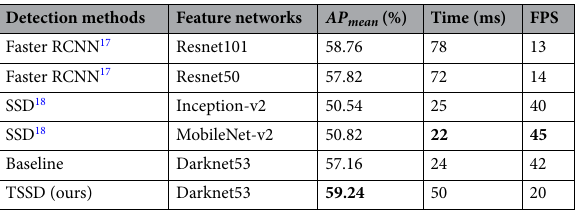
Table 2. Comparison of TSSD algorithm and various state-of-the-art detection methods. Significant values are in